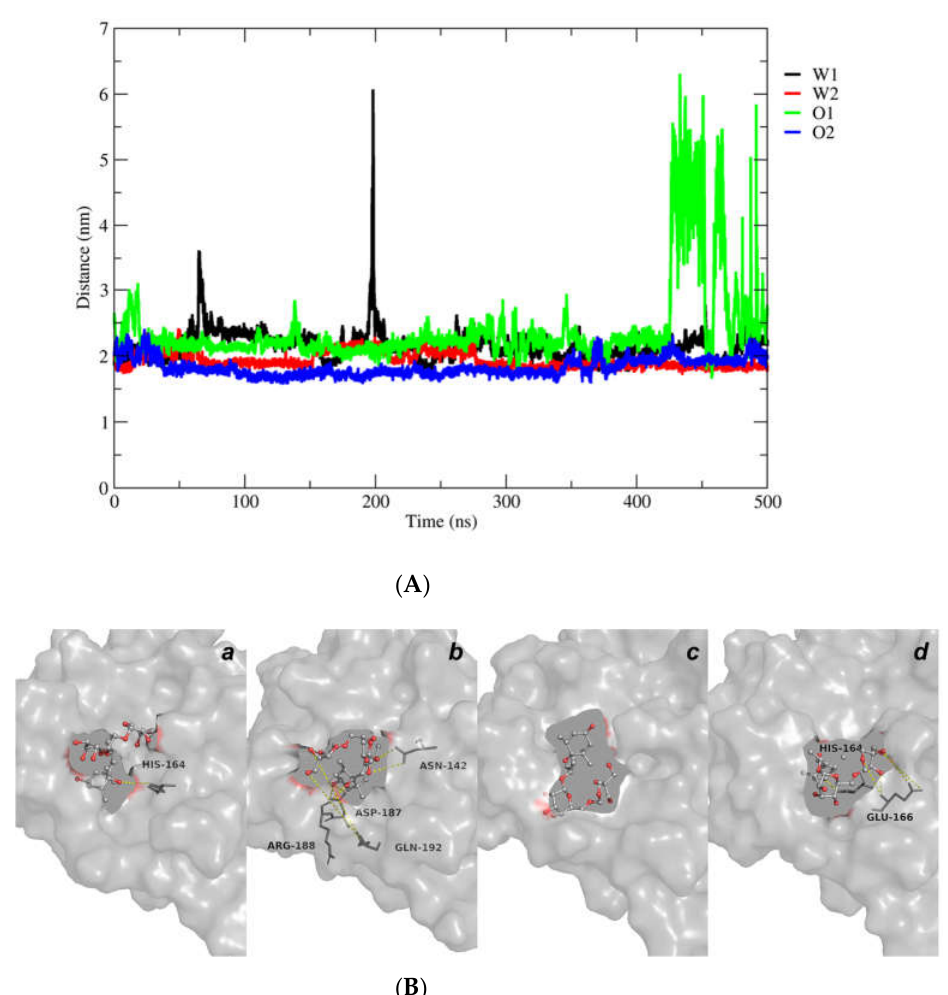
Figure 3. Protein-ligand center of masses distances along the L01 - M pro WT, (black), L02 - M pro WT (red), L01 - M pro O (green) and L02 - M pro O (blue) whole simulation complexes ( A ). Zoom view of the complex binding pose of the representative structures of M pro variants in complex with L01 and L02. The protein structures are shown in transparent surface and the main protein residue interactors and the compounds in sticks and spheres. L01 - M pro WT ( a ), L02 - M pro WT ( b ), L01 - M pro O ( c ) and L02 - M pro O ( d ) (B) .